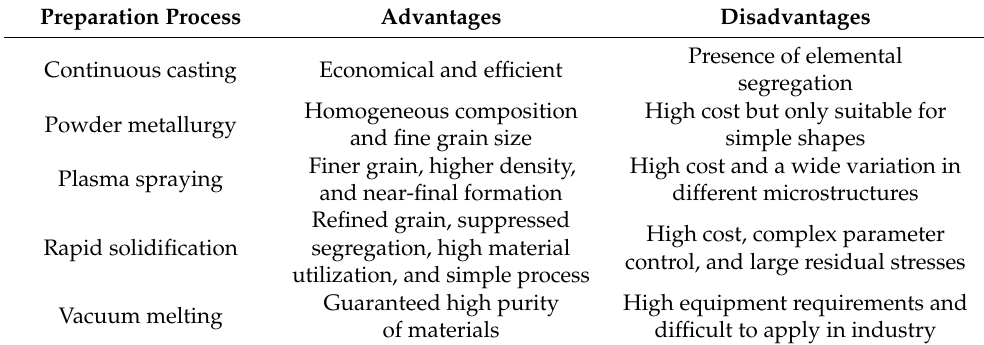
Table 1. The advantages and disadvantages of various methods of preparing Cu–Ni–Sn